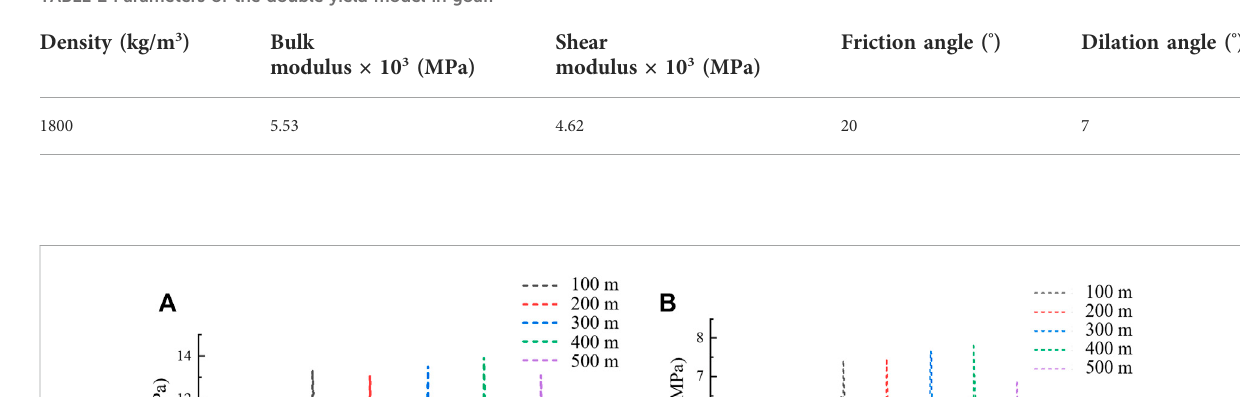
TABLE 2 Parameters of the double yield model in goaf.